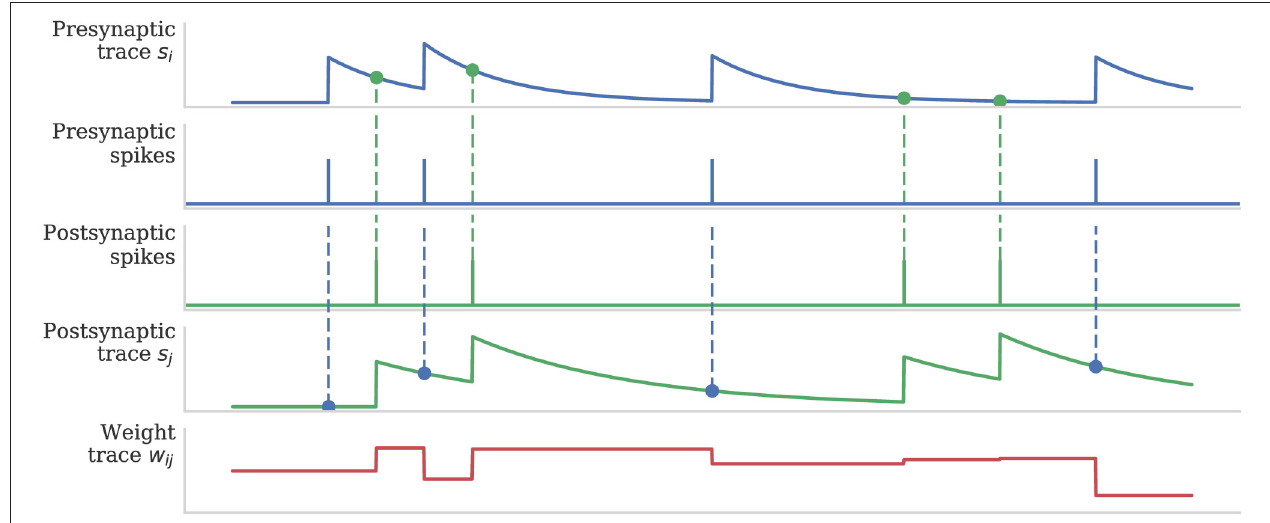
FIGURE 1 | Calculation of weight updates using pair-based STDP traces. Pre- and post-synaptic traces reflect spiking activity of pre- and post-synaptic neurons. Potentiation is calculated at each post-synaptic spike time by sampling the pre-synaptic trace (green circle) to obtain a measure of recent pre-synaptic activity. Depression is calculated at each pre-synaptic spike time by sampling the post-synaptic trace (blue circle) to obtain a measure of recent post-synaptic activity. Weight dependence is additive. After Morrison et al. (2008).